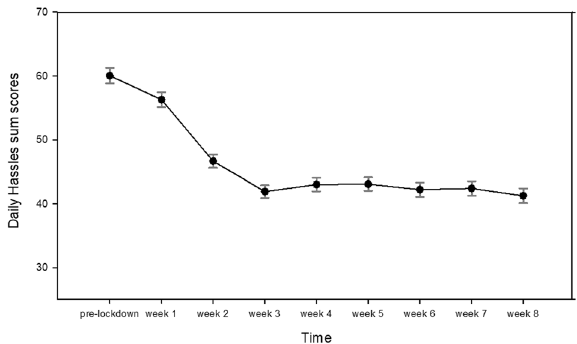
Fig. 2 Daily hassles pre- and during lockdown. Mean scores and standard errors of the occurence of daily hassles prior to the lockdown and during weeks 1 – 8.